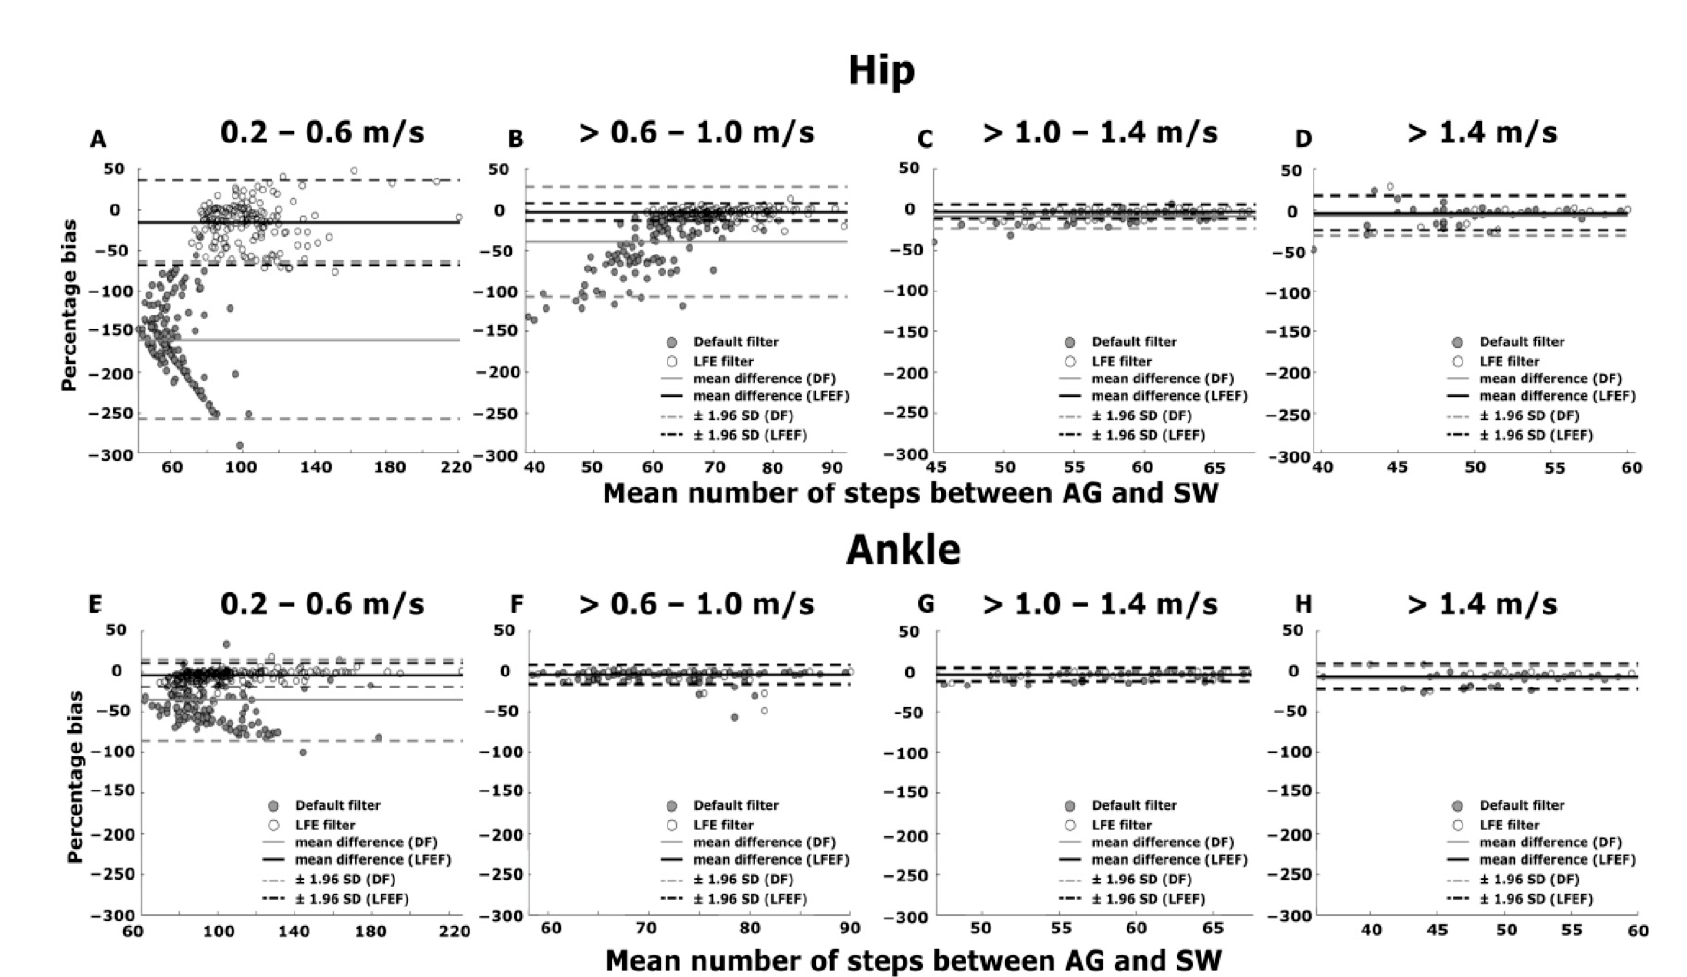
Figure 2. Bland–Altman plots for percentage bias between the hip worn AG and SW vs. the mean number of steps between the hip worn AG and SW using the DF and LFEF for gait speeds between ( A ) 0.2–0.6 m/s. ( B ) >0.6–1.0 m/s. ( C ) >1.0–1.4 m/s. ( D ) > 1.4 m/s during straight walking. Bland–Altman plots for percentage bias between the ankle worn AG and SW vs. the mean number of steps between the ankle worn AG and SW using the DF and LFEF for gait speeds between ( E ) 0.2–0.6 m/s. ( F ) >0.6–1.0 m/s. ( G ) >1.0–1.4 m/s. ( H ) > 1.4 m/s during straight walking. The grey and white filled circles represent the DF and LFEF, respectively. The grey and black solid line represents the mean percentage bias for the DF and the LFEF, respectively. The grey and black dashed line represents the ± 95% limits of agreement.